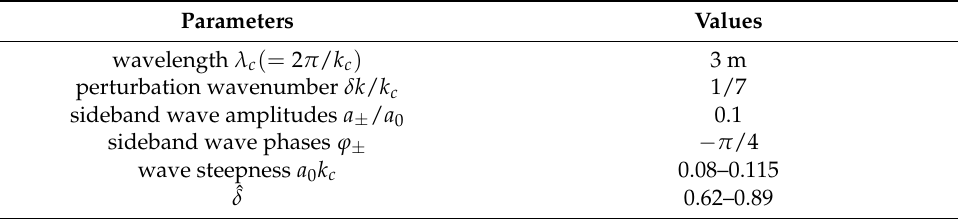
Table 1. Parameters defining the initial profiles of the modulated wave trains simulated with the